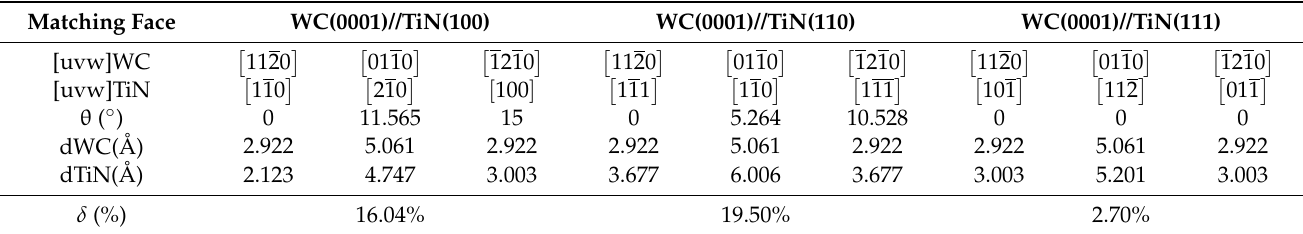
Table 5. Calculated lattice mismatch between WC and TiN.